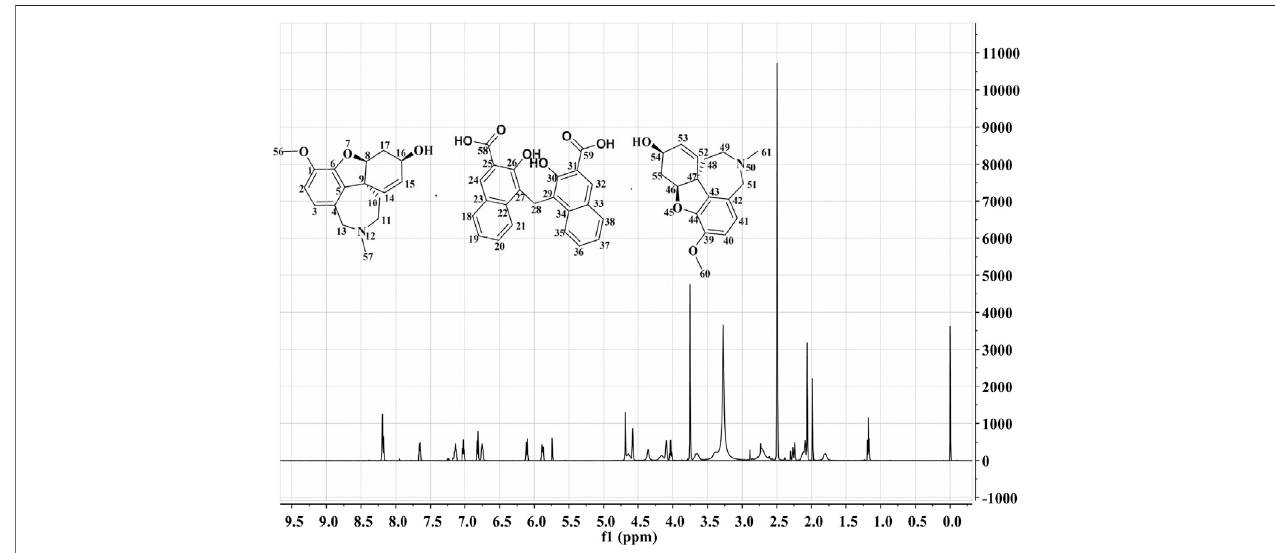
FIGURE 1 | The possible structure of GLT-PM and its 1 H-NMR spectra.